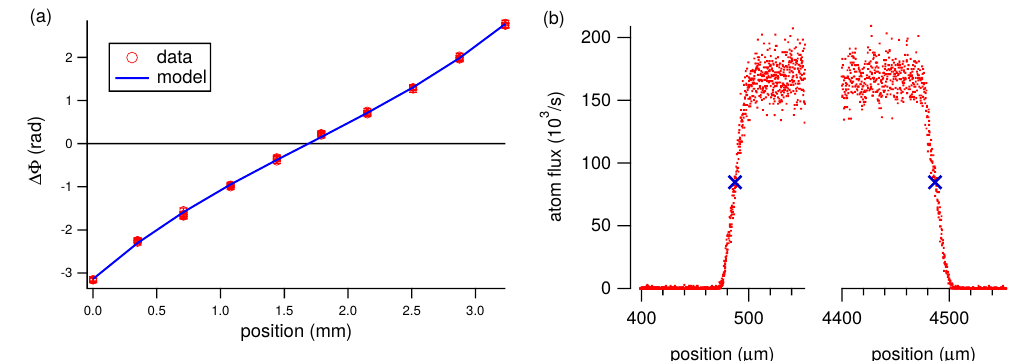
Figure 3. ( a ) Induced phase shift in the interferometer vs the lateral position of the electrodes with respect to the beam; ( b ) Observed atom beam flux as a function of the electrodes’ lateral position. We use these data to determine the distance between the electrodes.